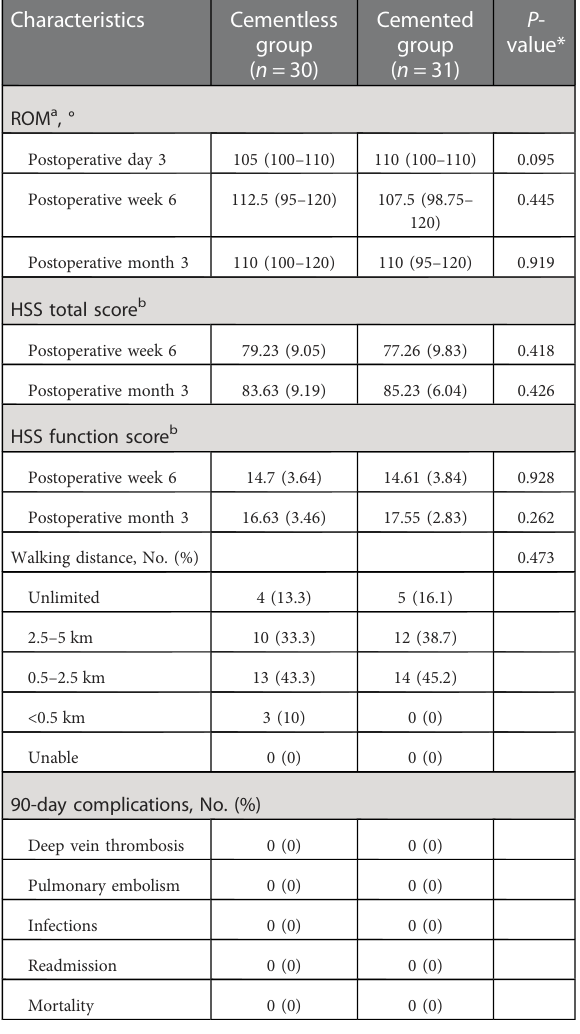
TABLE 3 Early Functional Recovery and Complications. Characteristics Cementless